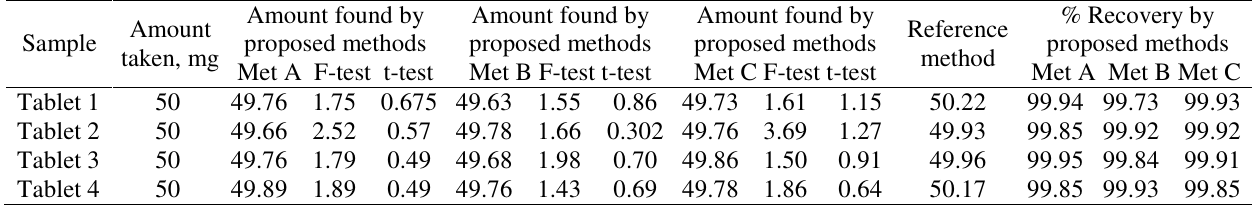
Table 2. Assay of CEFT in pharmaceutical